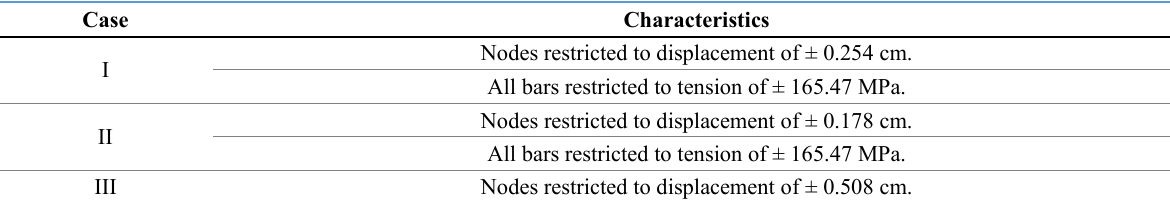
Table 3. Data from the analyzed cases [6].